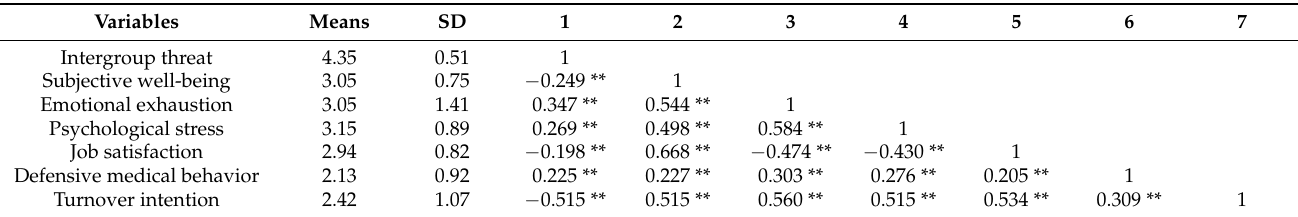
Table 5. Correlations among study variables ( n =